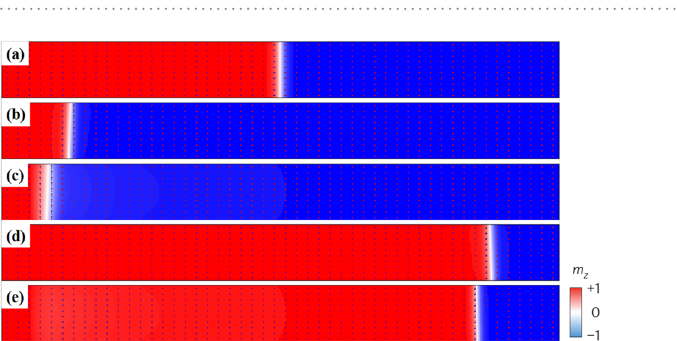
Figure 4. Current density dependence of the ( a ) average velocity, ( b ) terminal velocity, and ( c ) terminal azimuthal angle of domain wall moments in the nanotracks with magnetic anisotropy gradient.